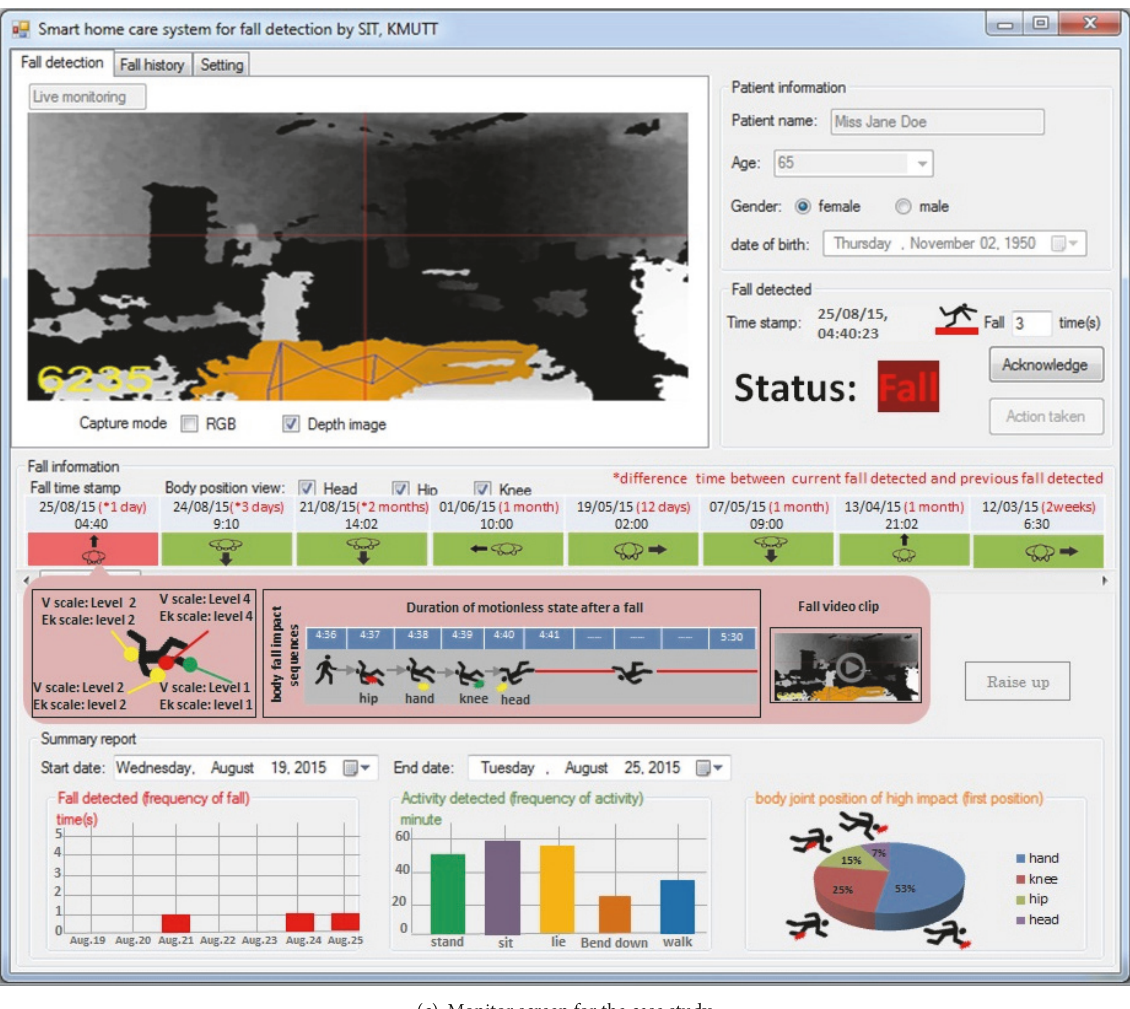
Figure 10: The case study for fall detection and fall severity level